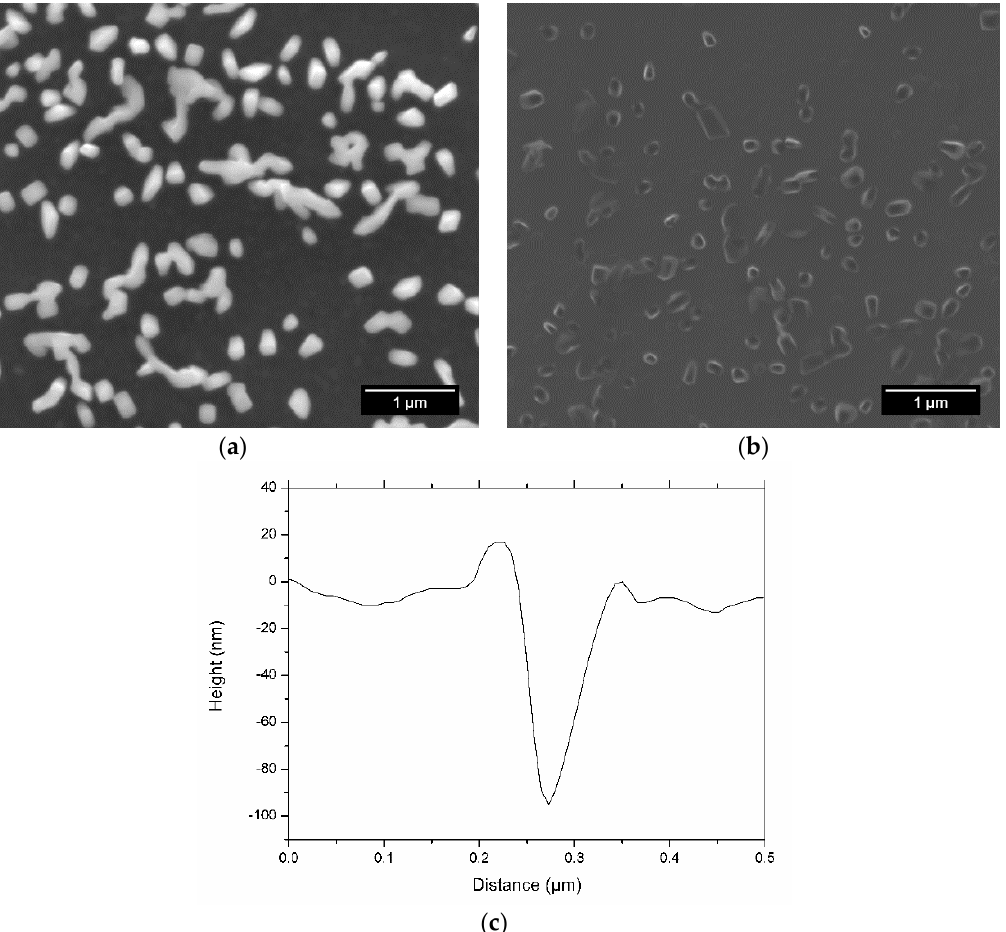
Figure 1. Zn-diamond-like carbon (DLC) sample with about 10 at.% Zn: ( a ) scanning electron microscope (SEM) image of the sample as prepared; ( b ) SEM image of the sample after etching; ( c ) atomic force microscopy (AFM) line scan of a hole in the etched sample.